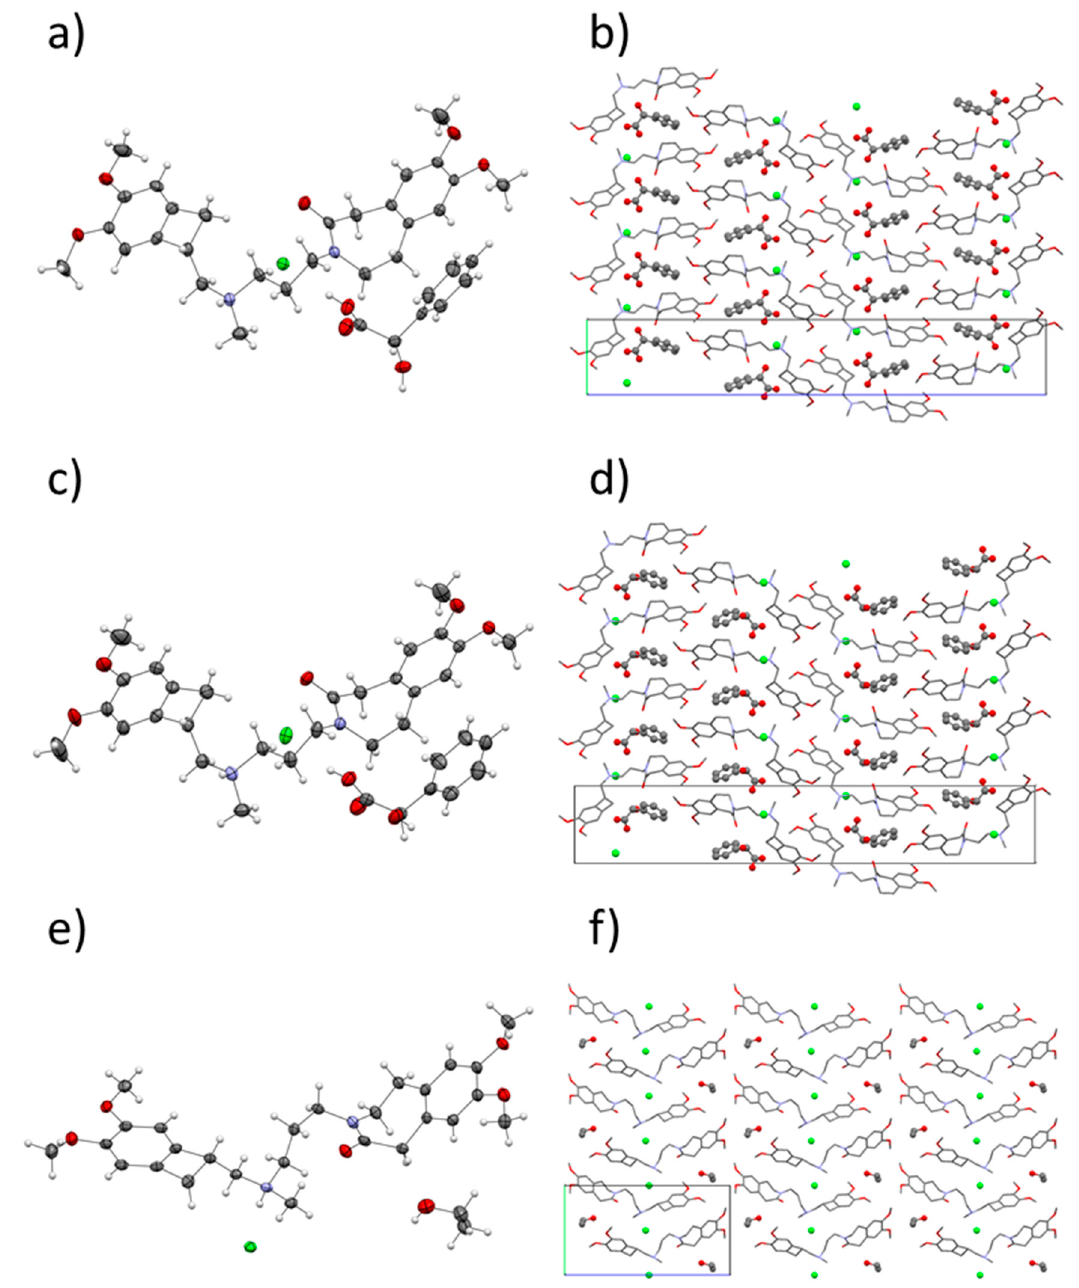
Figure 2. Crystal structures of IClSM ( a , b ), IClRM ( c , d ) and IClEt ( e , f ). Left: the asymmetric unit with the thermal ellipsoids. Right: the crystal packing with the unit cell.